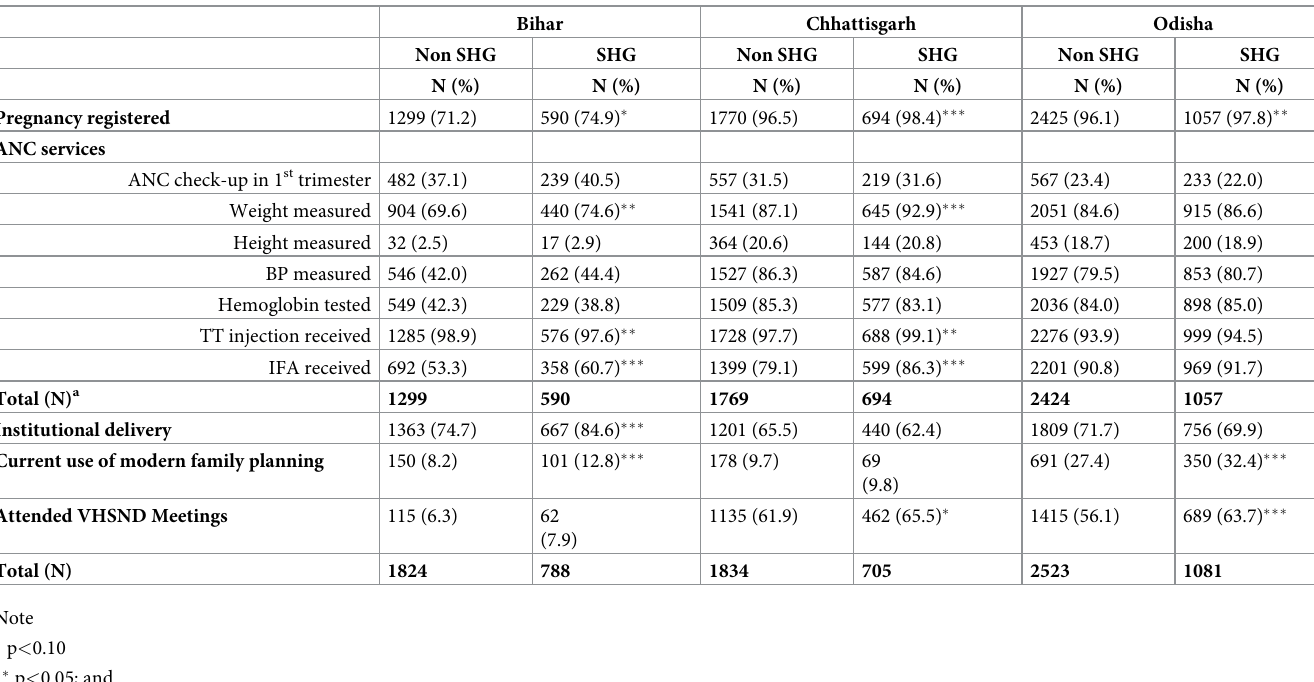
Table 8. Access to maternal health services among SHG and non-SHG member mothers of children under two years in Bihar, Chhattisgarh and